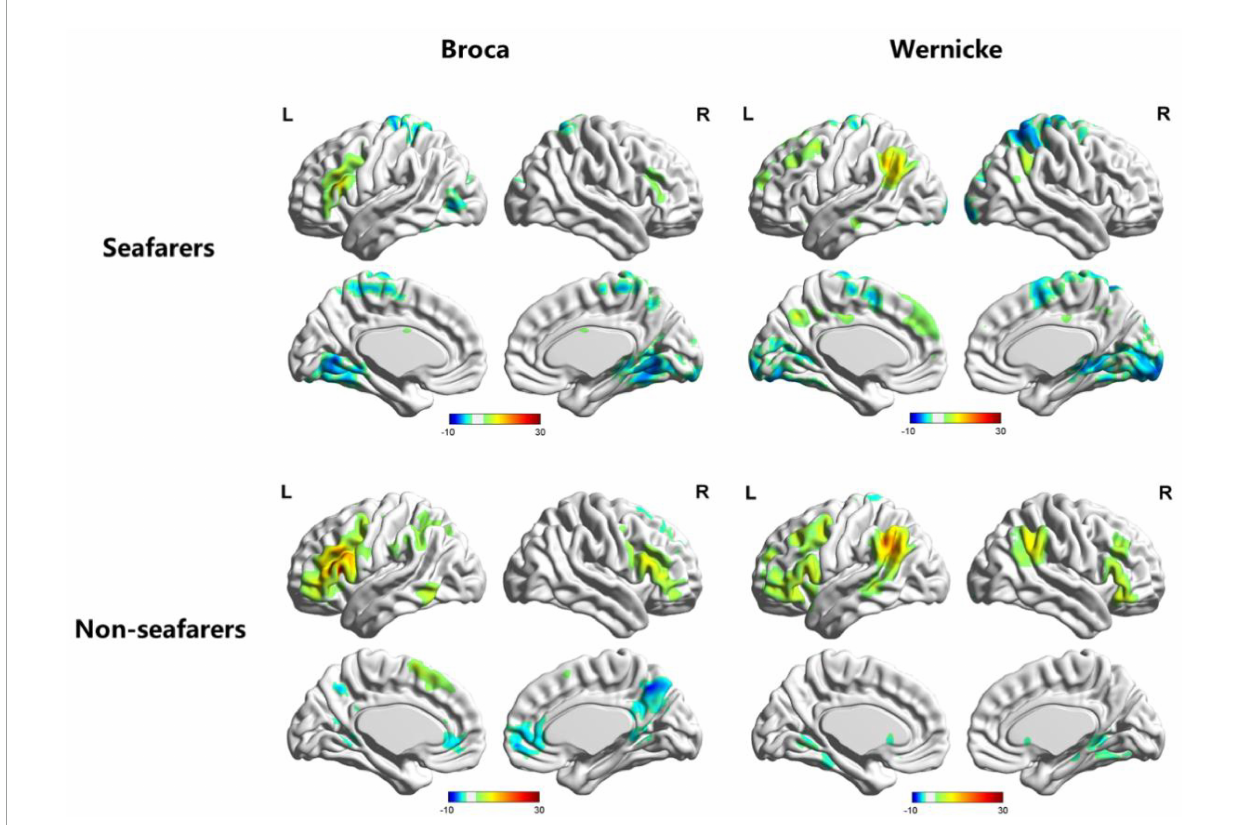
FIGURE1 Visualization of functional connectivity using Broca’s region and Wernicke’s region as the independent seeds in the seafarer and non-seafarer group ( p 0.005, cluster size > 200 voxels, corresponding to corrected p FWE 0.05). R: right hemisphere, L: left hemisphere.